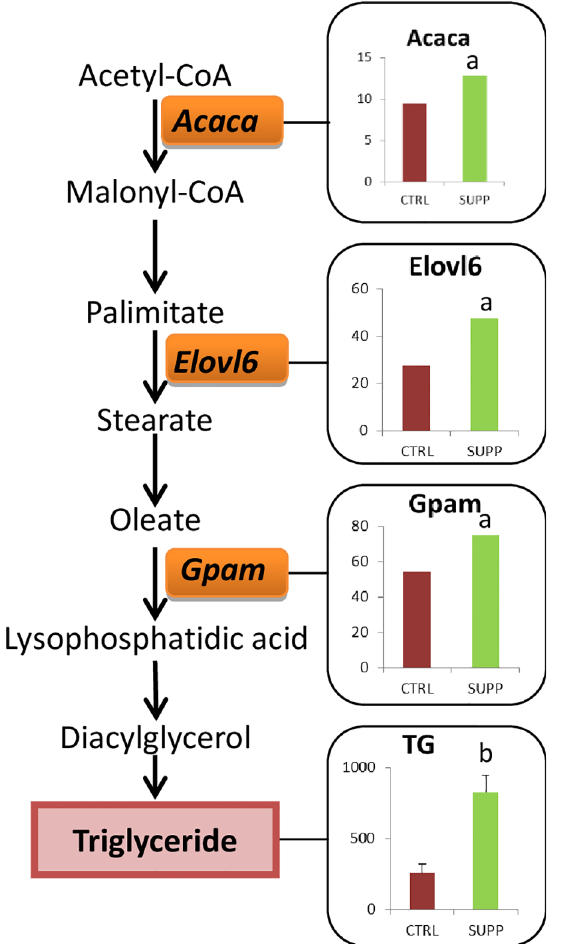
Exon Per Million Fragments Mapped (FPKM). Triglycerides are expressed as μ g/mg protein. CTRL, control; SUPP, supplemented (father ’ s diet). a q < 0.05, b p = 0.002 vs